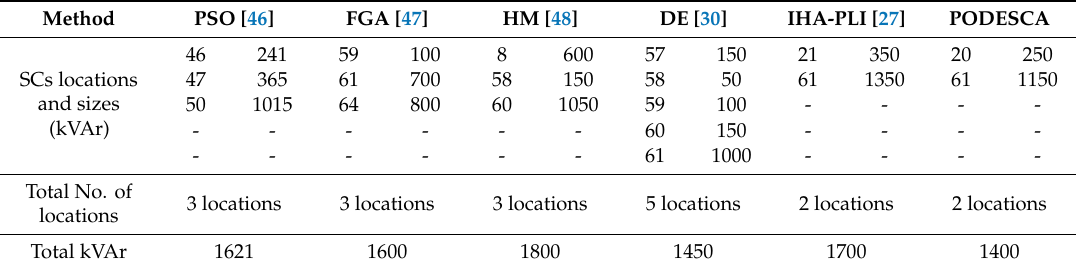
Table 3. Optimal locations and sizes of shunt capacitors (SCs) by PODESCA comparing to other methods for the 69-bus system.